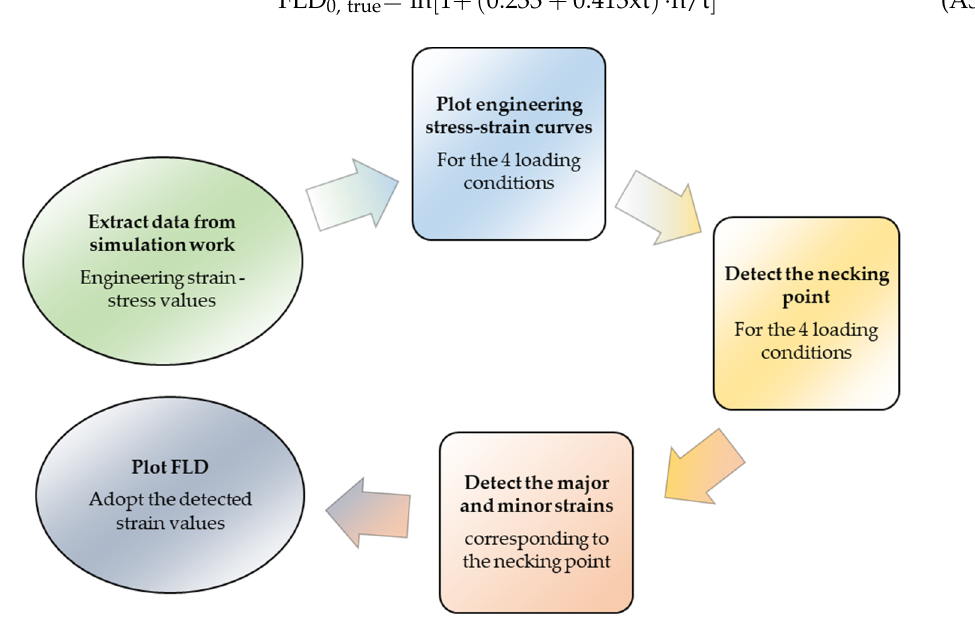
Figure A1. Process chart of plotting FLD via M-K approach.